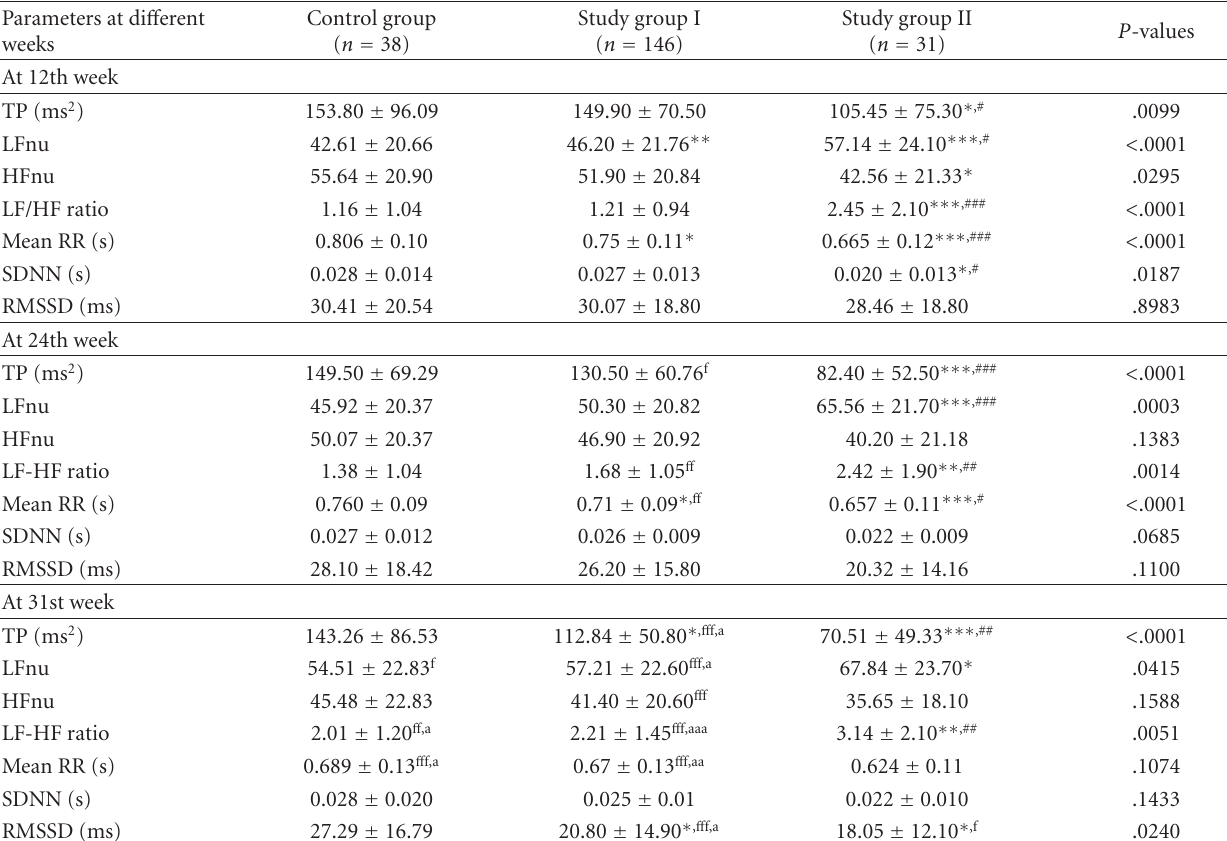
Table 2: Comparison of age, body weight (BW), body mass index (BMI), heart rate (HR), systolic blood pressure (SBP), and diastolic blood pressure (DBP) of the subjects of control group (subjects with normal pregnancy) with the subjects of study group I (those who had high risk for PIH, but did not develop PIH) and study group II (those who developed PIH later) at di ff erent weeks of